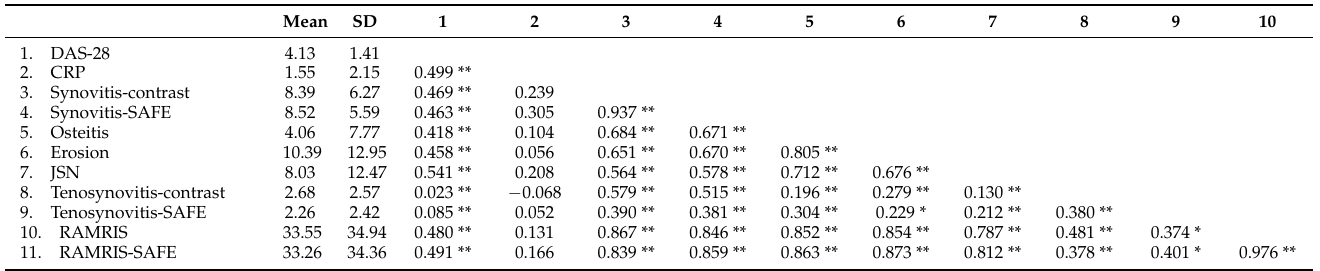
Table 3. Means, standard deviation (SD), and Spearman–Rho correlation matrix for imaging features of RAMRIS/RAMRIS-SAFE, DAS-28, and